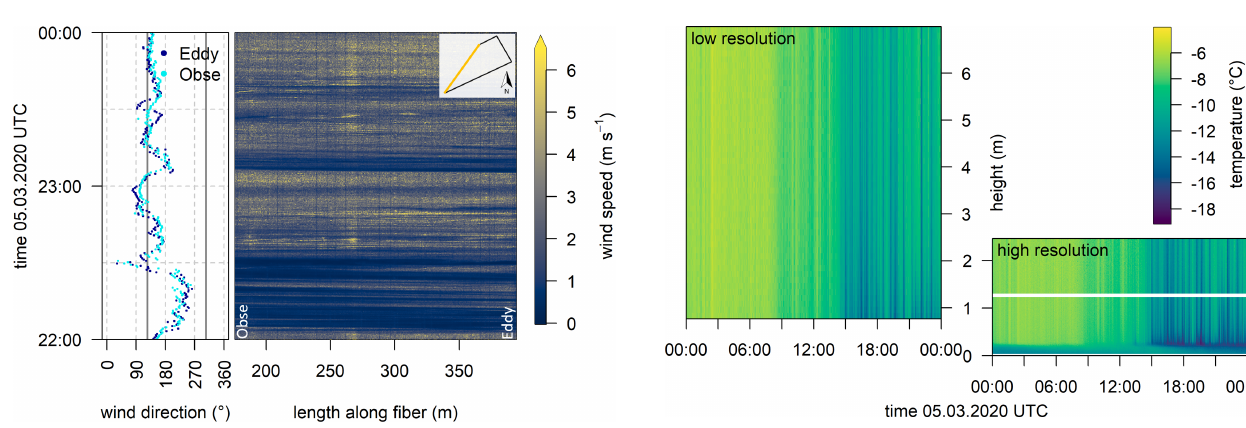
Figure 5. Fiber-optic wind speed along the OBSE–EDDY transect for the 5 March. For visualization purposes, some of the stronger artifacts created by fiber holders and marking tape (appearing as vertical lines) were removed using spatial interpolation. The heat- ing rate for this period was 1 . 6Wm − 1 . The left panel shows the ultrasonic wind direction (temporal resolution = 30s) at the OBSE and EDDY towers. Gray vertical lines indicate the wind directions orthogonal to the fiber, where wind speeds are not biased by the angular dependence of the method.